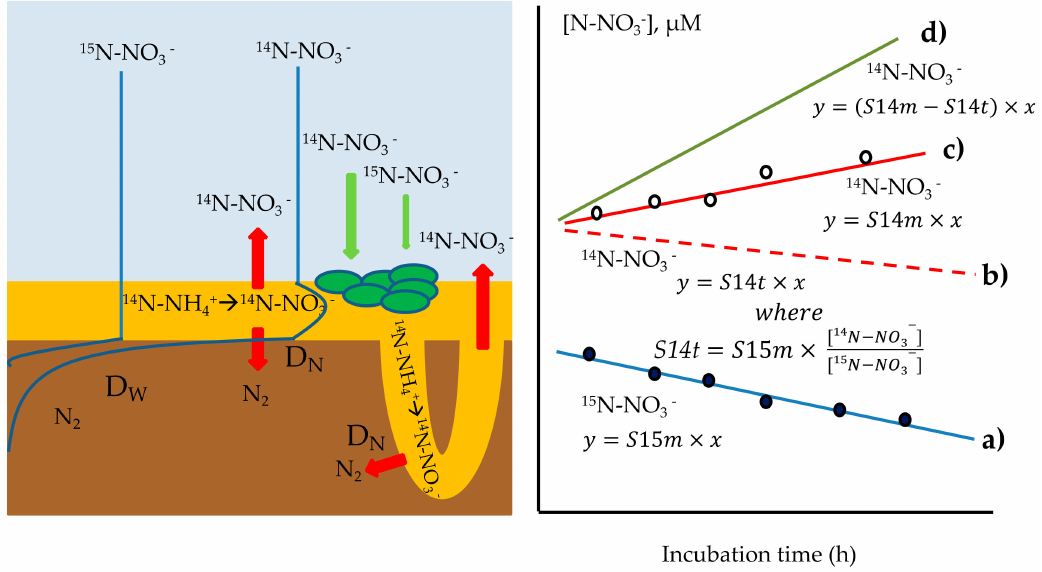
Figure 2. Graphical representation of the calculation of the e ffl ux of nitrate from the sediment to the water column due to nitrification ( 14 N-NO 3 − -e ffl ux). The theoretical uptake of 14 N-NO 3 − ( b ) is calculated from measured 15 N-NO 3 − consumption ( a ). The nitrate e ffl ux ( d ) is calculated